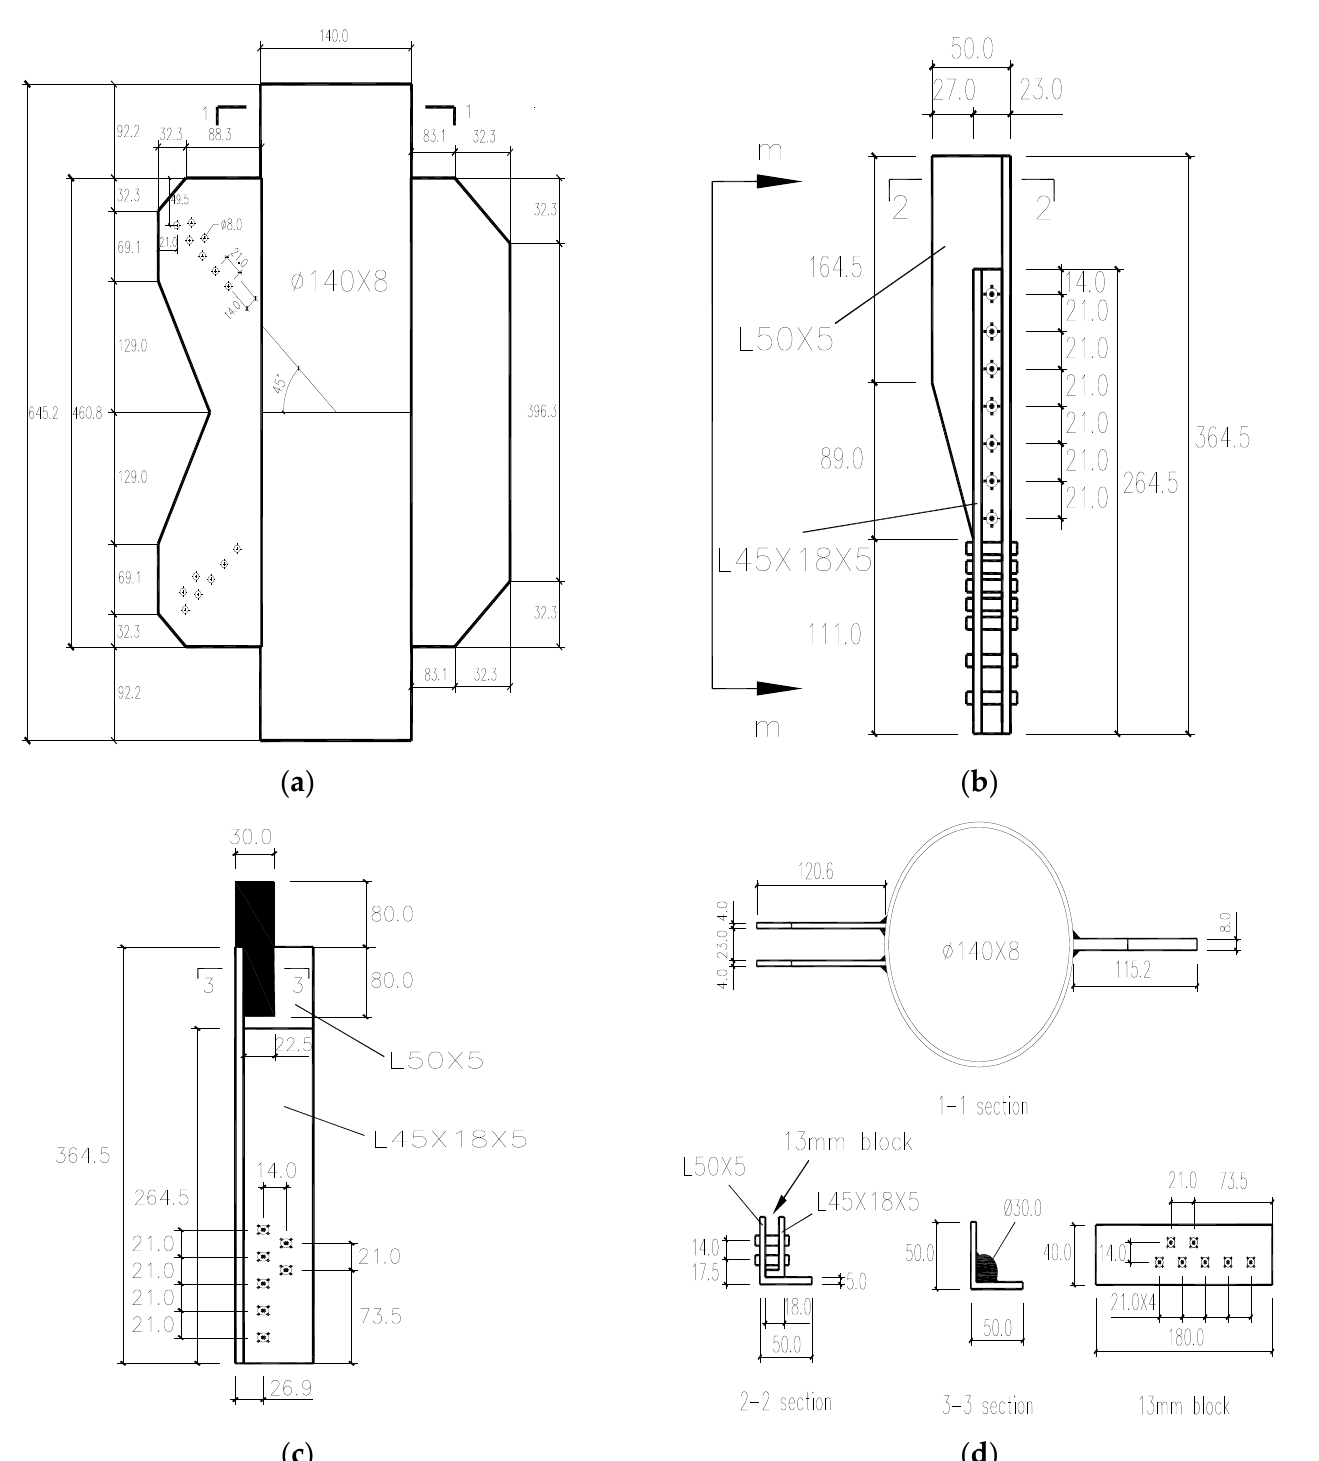
Figure 3. ( a ) Elevation of 1:5 scale model of DLDPJ; ( b ) connection diagram of long and short angle steel of 1:5 scale model of DLDPJ; ( c ) M-M side view of long and short angle steel of 1:5 scale model of DLDPJ; ( d ) 1-1, 2-2 and 3-3 sections and cushion blocks of 1:5 scale model of DLDPJ.